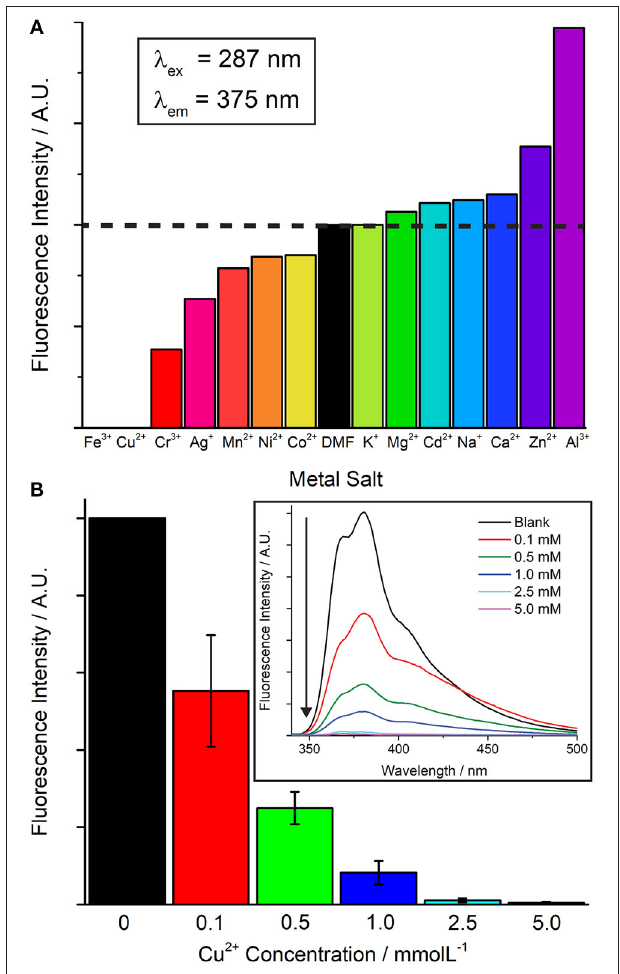
FIGURE 7 | (A) Changes in luminescence of samples of 5 when contacted with 5mM DMF solutions of metal nitrates. (B) Concentration dependence of turn-off sensing of Cu 2 + . Experiments carried out in triplicate, typical spectra for Cu 2 + sensing shown as an